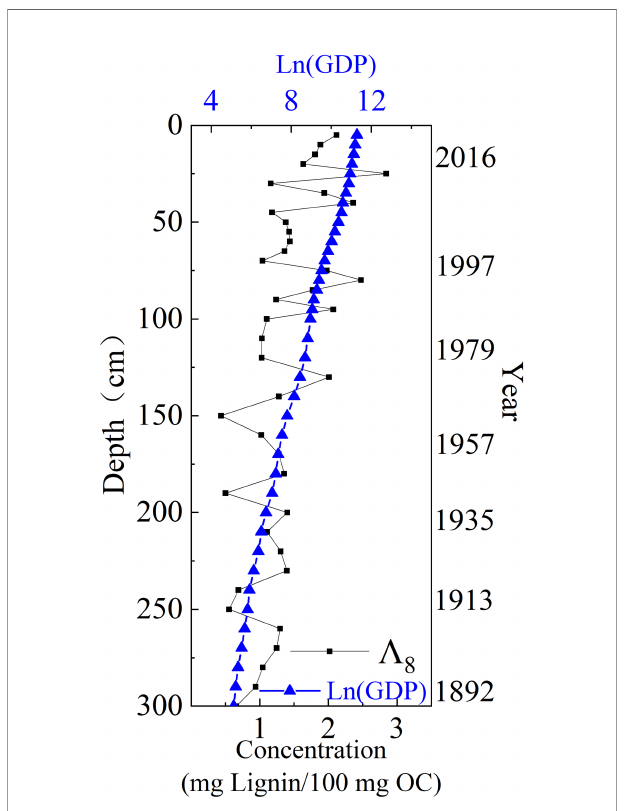
FIGURE 8 | Depth pro fi les of L 8 and Ln(GDP) in sediment cores of the